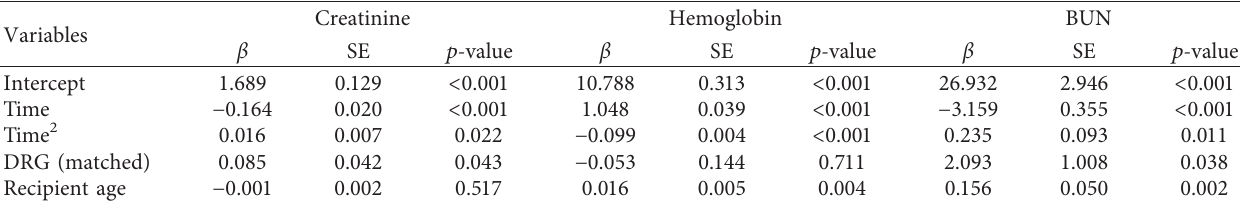
Table 1: The results of the multivariate longitudinal model (Stage 1).